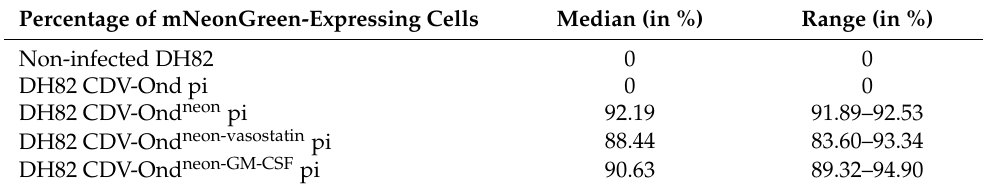
Table 1. Median and range of the number of CDV-Ond-infected cells assessed by CDV nucleoprotein (D110) immunofluorescence.